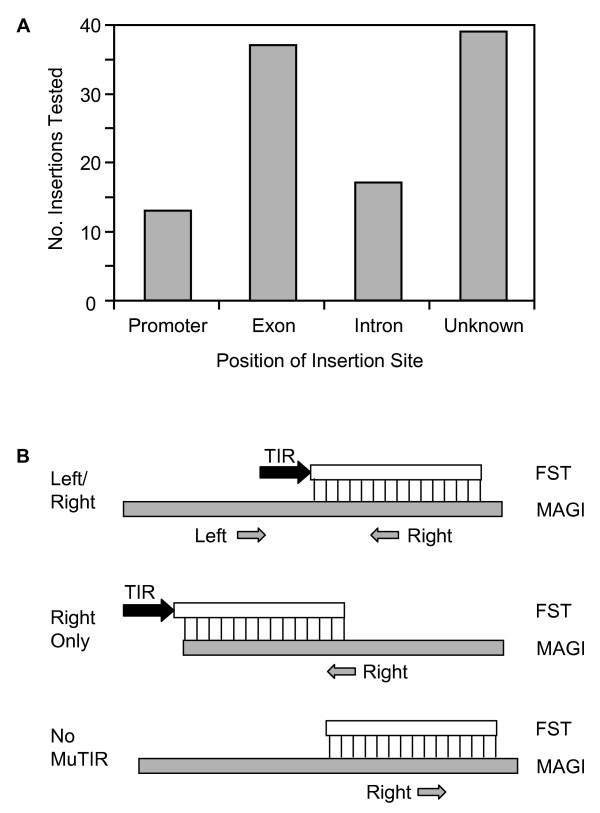
Informatic analysis of UniformMu FSTs validated by PCR. (A) Distribution of Mu insertion sites relative to transcribed maize sequences. (B) Schematics of the locus-specific primer design as constrained by available sequences. Left and right specific primers were designed when genomic sequence was available on either side of the insertion site. Right specific primers were designed when the insertion site defined novel maize genomic sequence. A presumptive right primer was designed for FSTs without a MuTIR sequence.